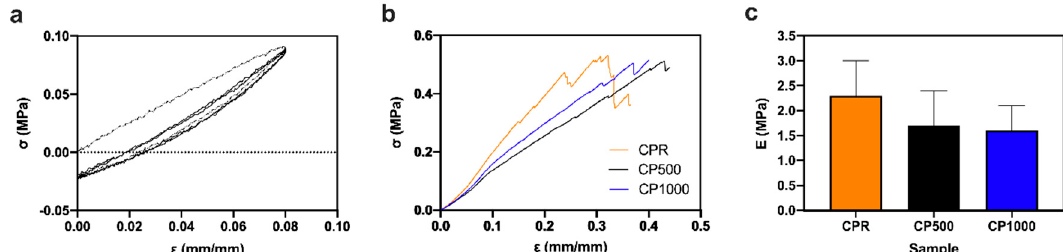
Figure 2. Uniaxial tensile tests on flat and micro-patterned patches in wet conditions: ( a ) representative preconditiong cycle for CPR specimens, ( b ) tensile tests up to break, and ( c ) Young modulus (E).